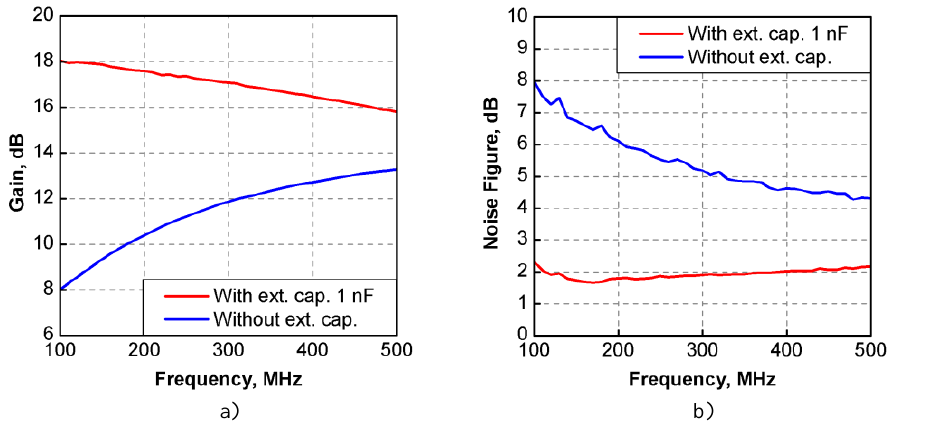
Fig. 5. Measured gain (a) and noise figure (b) versus frequency for the proposed